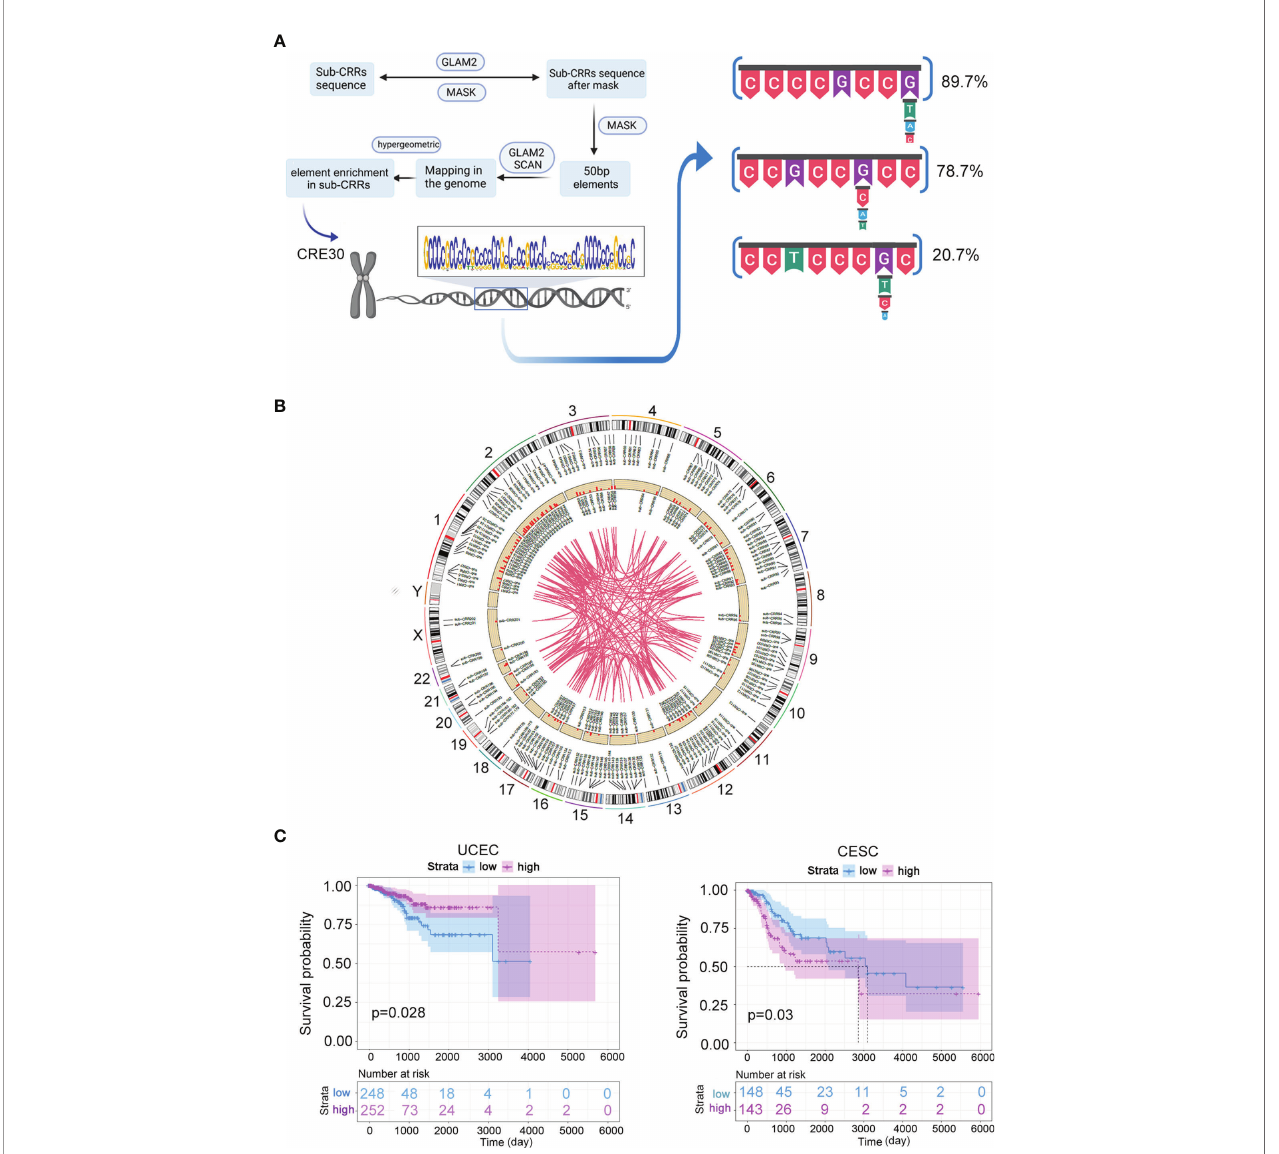
FIGURE 2 | CRE30 enriched in sub-CRRs and associated with clinical case survival. (A) Schematic presentation of the conserved DNA element prediction pipeline performed in this study based on the MEME program. Representative segments of CRE30 were obtained through searching of matched sequences in the reference genome (hg19); the repeat motifs that frequently appeared are shown on the right side. (B) The circus plot illustrates the locus information of sub-CRRs and CRE30s on chromosomes in the UCEC genome. The outer circle is the location of sub-CRRs on chromosomes, and the inside circle is the location of sub-CRRs containing CRE30. The histogram shows the proportion of other CRRs that have strong correlations (r > 0.6) with the given sub-CRR; the maximum ordinate is 1. The curves in the center connect sub-CRRs with strong correlations (r > 0.6). (C) Survival curves of UCEC and CESC clinical groups classi fi ed by genes in sub-CRRs with